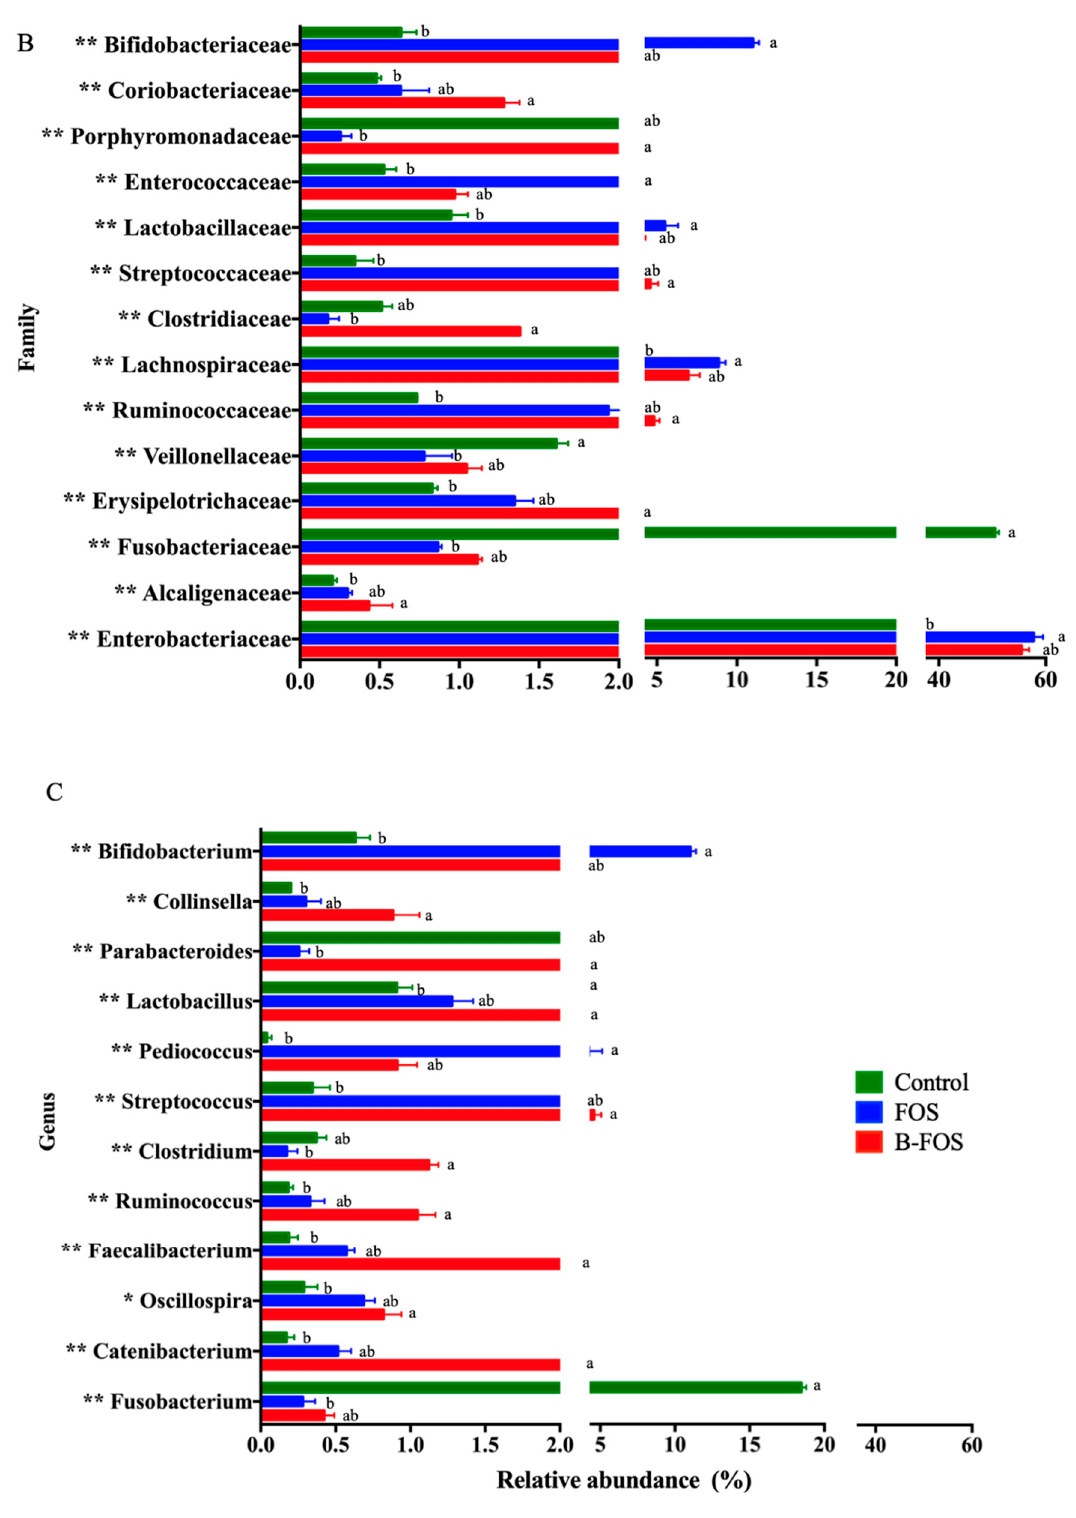
Figure 6. Taxonomic di ff erences in fecal microbiota. Comparison of relative abundance at the bacterial phylum ( A ), family ( B ) and genus levels ( C ). Error bars represent means ± SD of triplicate cultures. Treatments with di ff erent letters are significantly di ff erent at p < 0.05. Relative abundance > 0.5%. * p < 0.05, ** p < 0.01.